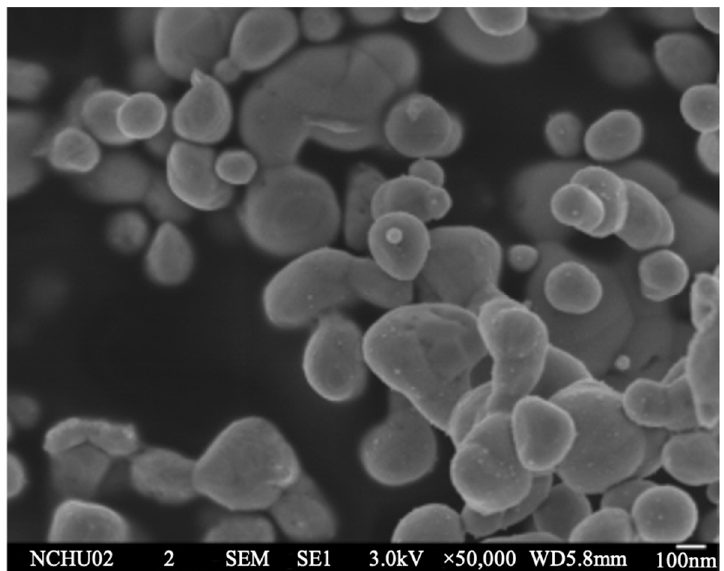
Figure 4. SEM image of spray pyrolyzed submicron Ag particles.